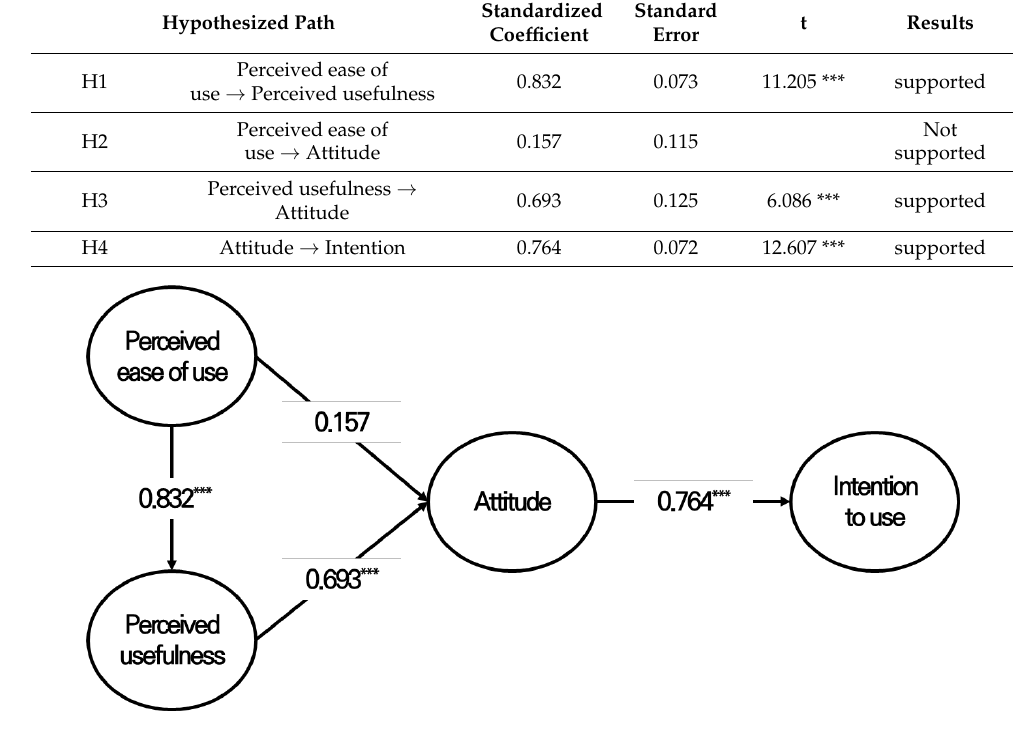
Table 4. Summary of the tested hypotheses (Screen golf + Screen baseball).